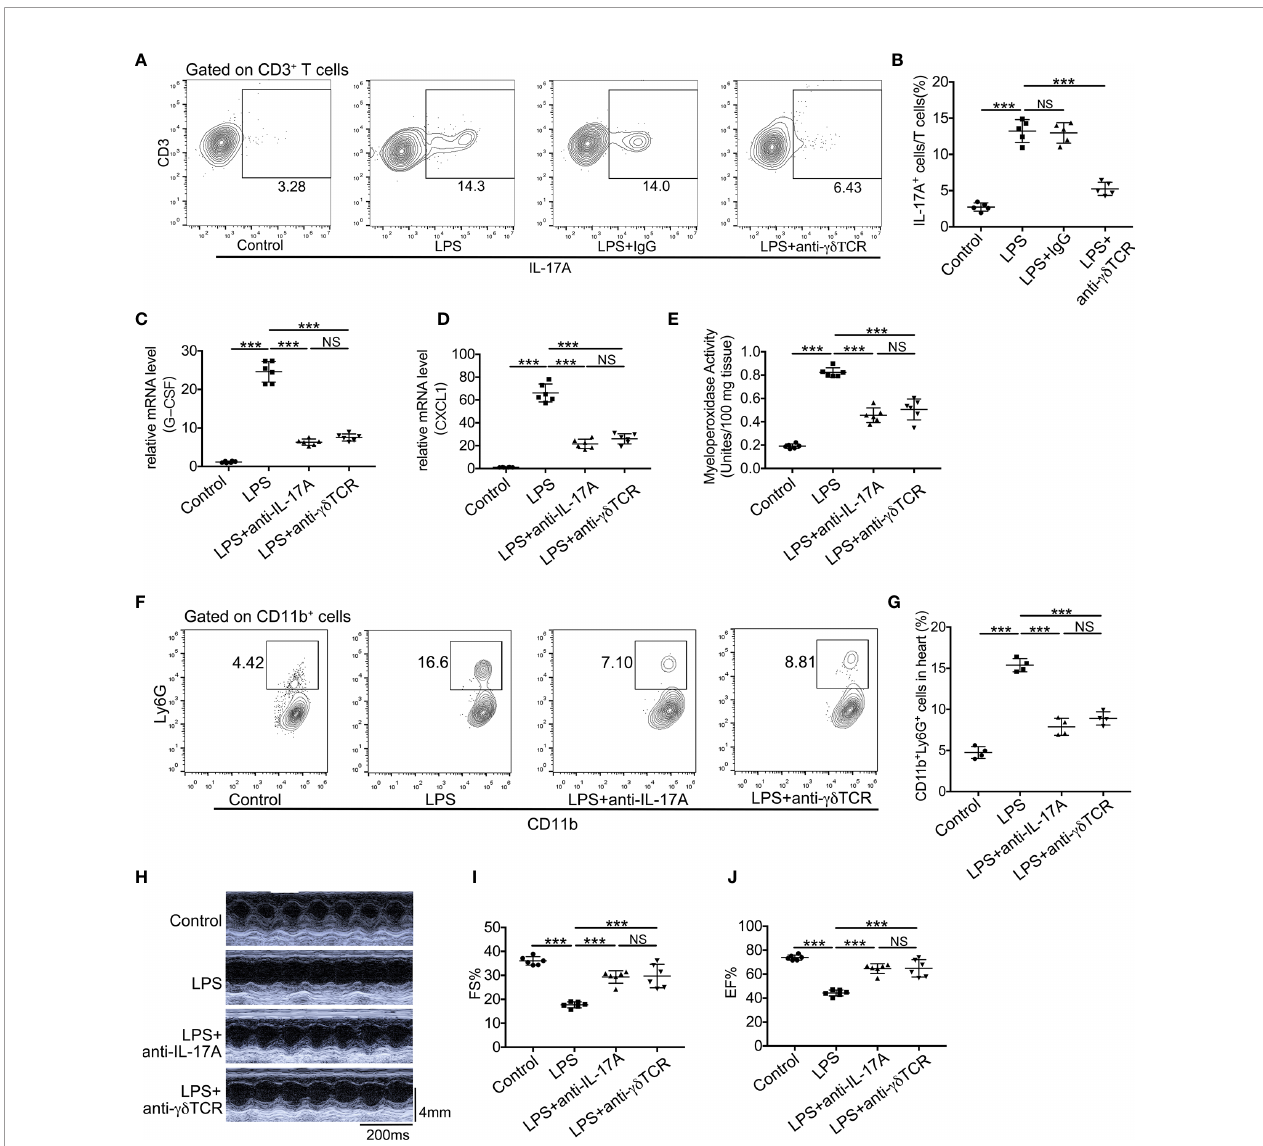
FIGURE 6 | Neutralization of IL-17A or depletion of gd T cells reduced neutrophil in fi ltration and improved cardiac function in LPS-induced cardiac injury. Cardiac function was determined using small animal ultrasound and cardiac tissues were collected 12 h after stimulation with LPS. (A, B) IL-17A + cells in all CD3 + T cells were examined by fl ow cytometric analyses (n = 5). (C, D) mRNA levels of G-CSF and CXCL1 were analyzed using quantitative PCR (n = 6). (E) Cardiac myeloperoxidase activity was examined by MPO test kit (n = 6). (F, G) Flow cytometric analyses of the percentage of CD11b + Ly6G + neutrophils in hearts (n = 4). (H) Representative cardiographic images of M-mode. (I, J) . Left ventricular FS and EF were determined by Echocardiographic analysis (n = 8). Data are shown as means ± SD. *** P < 0.001; NS, not signi fi